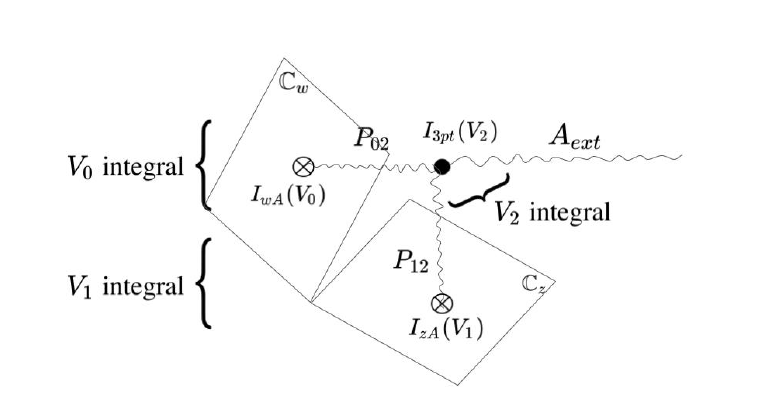
Figure 11: The 1-loop Feynman diagram for the OPE between two transverse surface defects on (cid:67) and (cid:67) planes. All the ingredients are explicitly z w